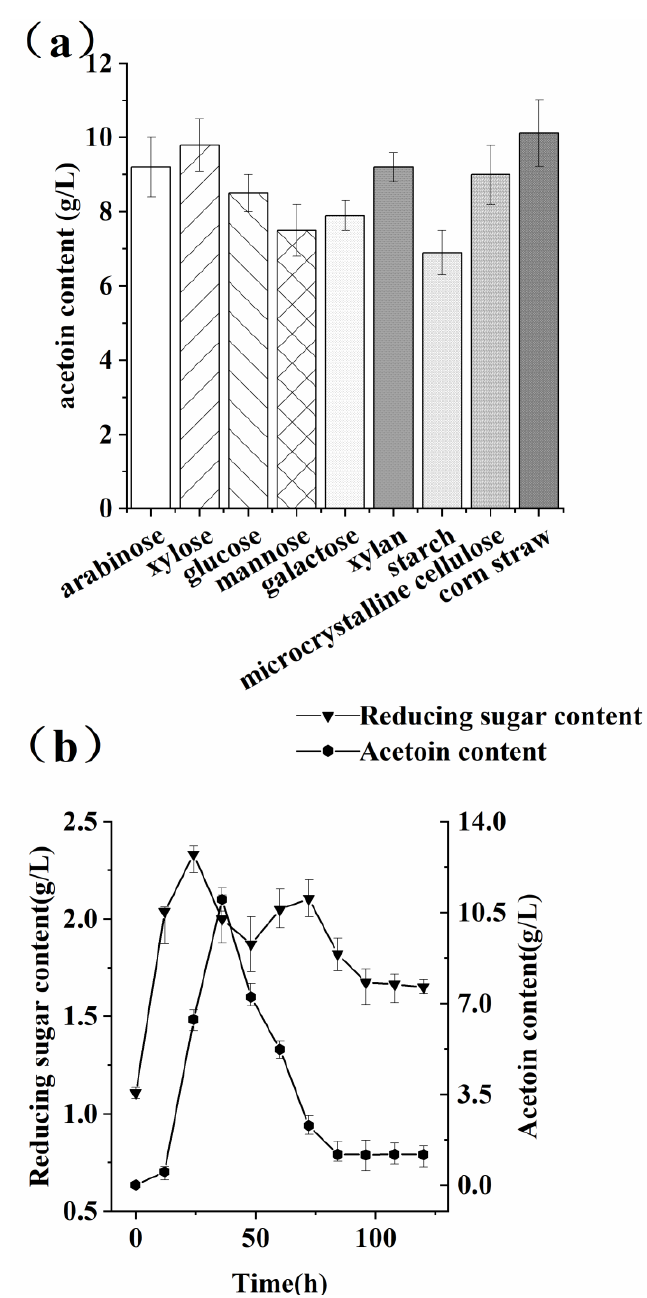
Figure 2. Acetoin production of TYF-LIM-RU47 on different substrates ( a ), changes of acetoin concentration and reducing sugar concentration during fermentation with corn straw as carbon source ( b ). The experiment was repeated three times, and the error bars corresponded to the standard deviation (SD).